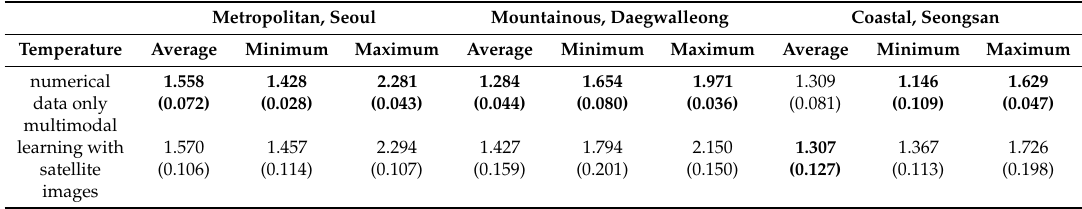
Table 20. Forecasting results, represented using the MAE for multimodal